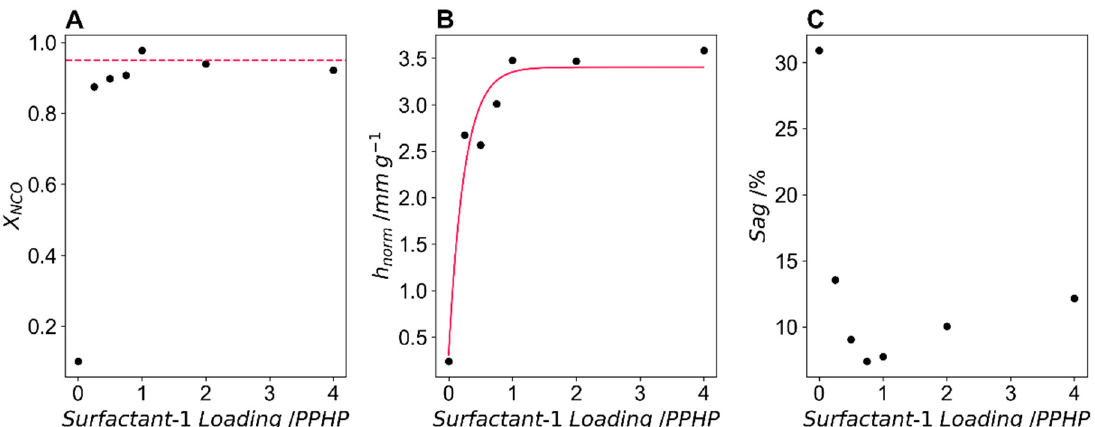
Figure 4. ( A ) Isocyanate conversion as a function of surfactant-1 loading, the dashed line indicates the predicted conversion at the constant catalyst loading. ( B ) The normalised maximum height (height divided by foam mass) of the foam as a function of surfactant loading-1 with the solid line indicating an exponential decay fit of the data. ( C ) The foam sag in percent as a function of surfactant-1 loading.